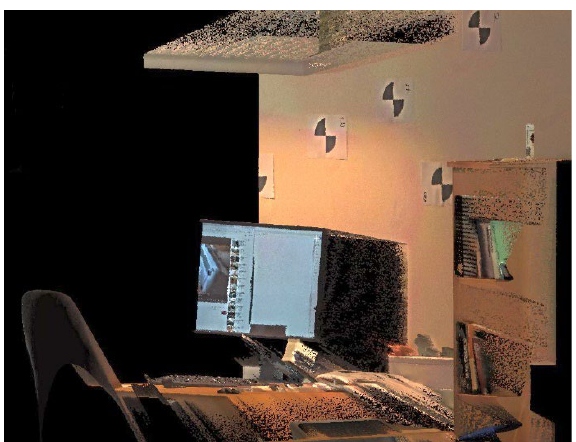
Figure 3. Reference LiDAR point cloud of a corner area.